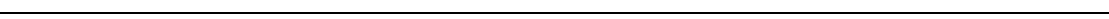
Fig. 4 OTUD1 interacts with YAP and antagonizes its K63-linked ubiquitination. a SFB-tagged DUBs were co-transfected with MYC-YAP into HEK293T cells, followed by pulldown with S-protein beads and immunoblotting with antibodies against FLAG and MYC. b Seven SFB-DUBs were co- transfected with MYC-YAP and HA-ubiquitin into HEK293T cells, followed by immunoprecipitation with anti-MYC beads and immunoblotting with antibodies against HA and MYC. c The HEK293T SFB-YAP stable cell line was transfected with four YAP-interacting DUBs along with an 8× GTIIC luciferase reporter and a TK-Renilla luciferase reporter. Reporter activity was measured 48 h after transfection. Error bars are s.e.m. Statistical signi fi cance was determined by a two-tailed, unpaired Student ’ s t -test. * P < 0.05; ** P < 0.01; *** P < 0.001. n = 3 biological replicates. d Co-immunoprecipitation of endogenous OTUD1 with endogenous YAP. e In vitro binding of puri fi ed GST-OTUD1 to puri fi ed His-YAP. f HEK293T cells were co-transfected with SFB- OTUD1 (wild-type, C320S or H431R), HA-ubiquitin and MYC-YAP, followed by immunoprecipitation with anti-MYC beads and immunoblotting with antibodies against HA and MYC. g Ubiquitinated SFB-YAP was puri fi ed with S-protein beads and incubated with His-OTUD1 (wild-type or C320S) puri fi ed from bacteria. After the in vitro deubiquitination reaction, the bound proteins were eluted by boiling in Laemmli sample buffer and immunoblotted with antibodies against HA, FLAG, and OTUD1. h HEK293T cells were co-transfected with SFB-OTUD1, HA-ubiquitin (wild-type, K48R or K63R) and MYC-YAP, followed by immunoprecipitation with anti-MYC beads and immunoblotting with antibodies against HA and MYC. i siRNA targeting OTUD1 was transfected into the HEK293T SFB-YAP stable cell line. Forty-eight hours later, cells were transfected with HA-ubiquitin (wild-type, K48R or K63R), followed by pulldown with S-protein beads and immunoblotting with antibodies against HA and FLAG. j Total K63-linkage speci fi c ubiquitinated proteins in control or OTUD1 knockout HEK293A cells (generated by CRISPR-Cas9) were immunoprecipitated by a K63-linked polyubiquitin-speci fi c antibody, followed by immunoblotting with antibodies against YAP and